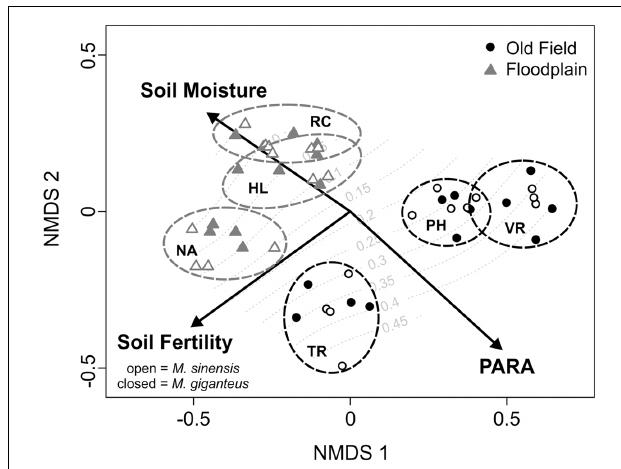
FIGURE 1 | Non-metric multidimensional scaling (NMDS) ordination of plots based on habitat variables. Vectors indicate the direction of change in environmental factors associated with the distribution of sites in multivariate space. Final proportional survival of Miscanthus plantings is overlaid as a response surface in gray. Old field sites are black circles, whereas floodplain sites are gray triangles. Open points are M. sinensis plots, and filled points are M. giganteus . Sites are enclosed by dotted ovals colored according to habitat. Old fields: PH, Phillips; TR, Trelease; VR, Vermillion River. Floodplain forests: HL, Homer Lake; NA, Nanney; RC, Richter.